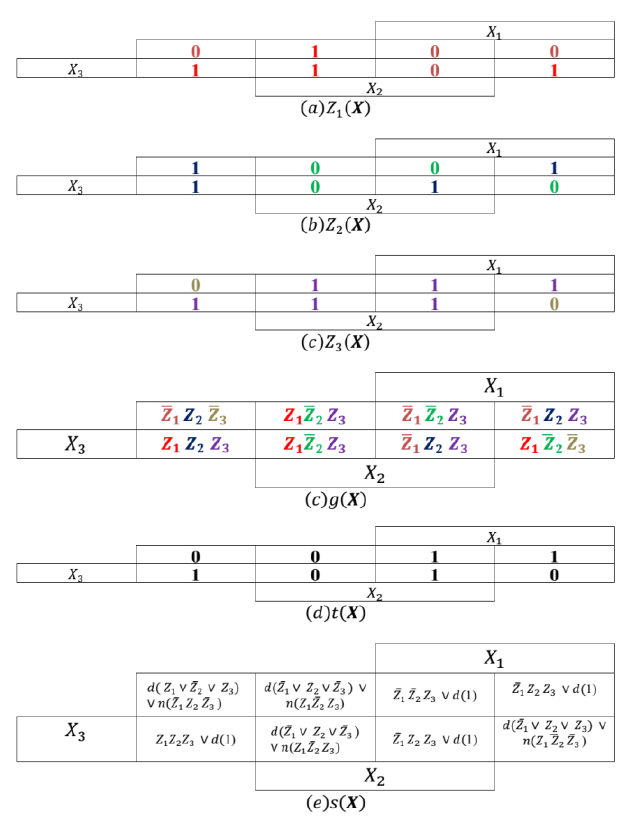
Fig. 3. Maps illustrating the evolution of the solution of the Example in Sec. 4